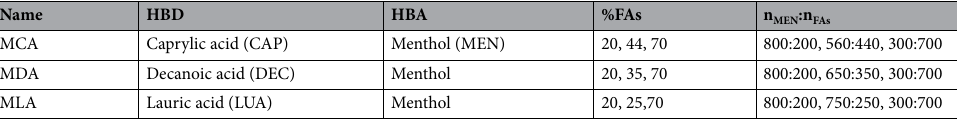
Table 1. Names of the simulated eutectic solvents and their different combinations (HBD and HBA) with abbreviations, and the MEN: FAs ratios in the binary